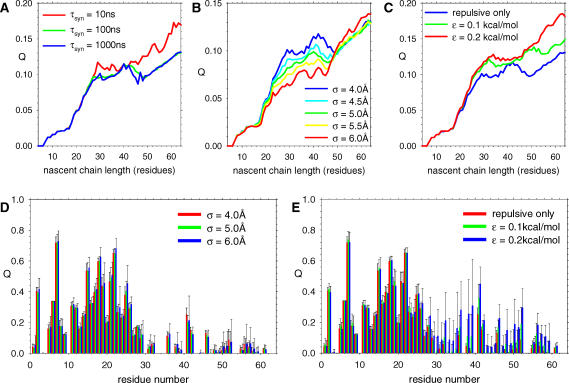
Parameter Sensitivity of Coupled Synthesis–Folding Simulations of CI2(A) Mean values of Q during coupled synthesis–folding of CI2 comparing the effects of using different timescales for amino acid synthesis (τsyn).(B) Same as (A), but comparing the effects of assigning larger radii to ribosome pseudo-atoms.(C) Same as (A), but comparing the effects of including energetically favorable interactions between the nascent protein and the ribosome.(D) Distribution of mean Qres values obtained during the synthesis of the final amino acid, comparing the effects of assigning larger radii to ribosome pseudo-atoms; error bars indicate the standard deviation of values obtained from 30 independent trajectories.(E) Same as (D), but comparing the effects of including energetically favorable interactions between the nascent protein and the ribosome.